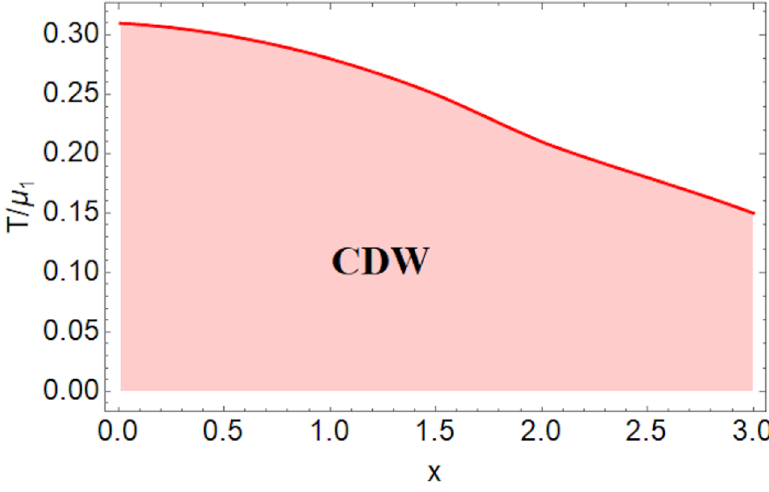
Figure 2 . The CDW phase diagram in ( x , T )